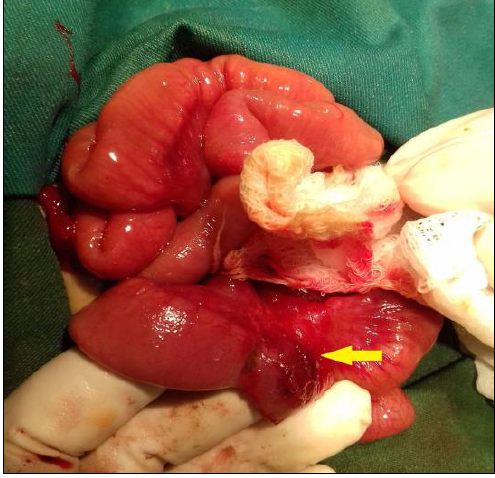
Figure 2: Mass causing intestinal obstruction due to pressure on its lumen. The postoperative recovery was smooth. Histopatho- logical examination of the lesion confirmed it to be a dermoid cyst of ovarian origin containing ectodermal and mesodermal